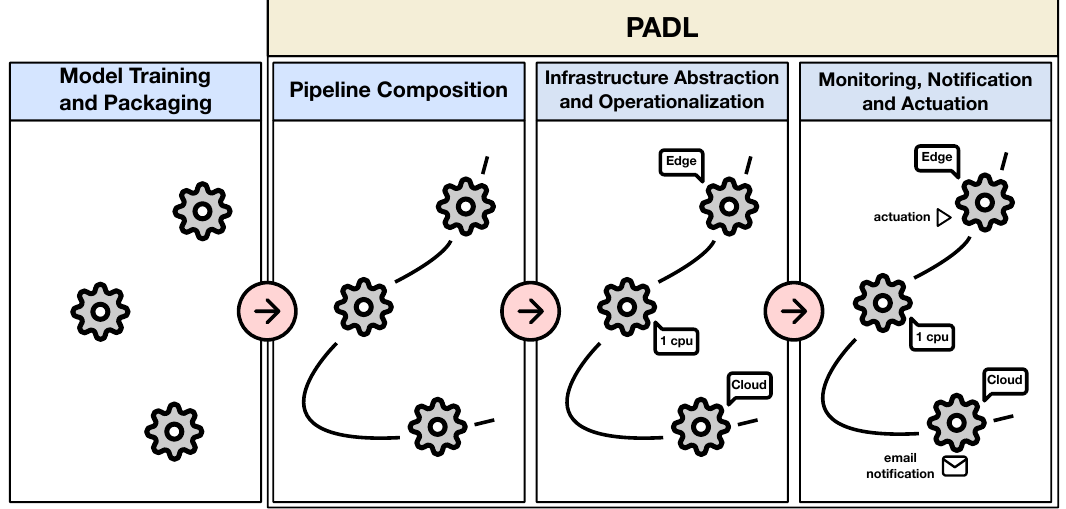
Figure 2. Definition and operation of analytical pipelines through the functionalities provided by PADL.